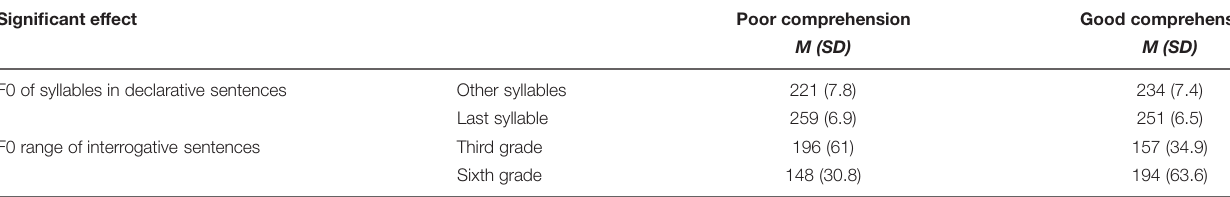
TABLE 4 | Mean and SD of the principal significant effects in the sentences analyses.